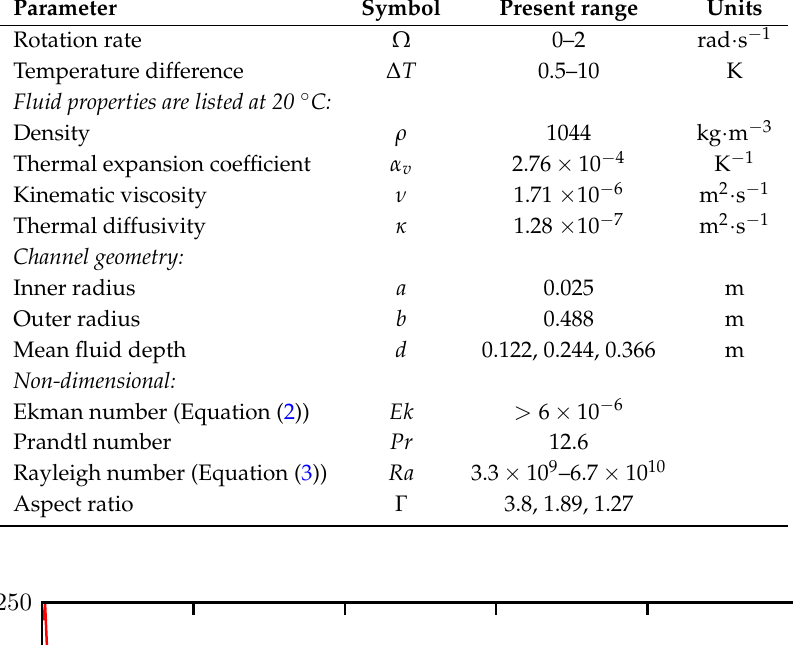
Table 1. Parameters used in the experiments described herein.